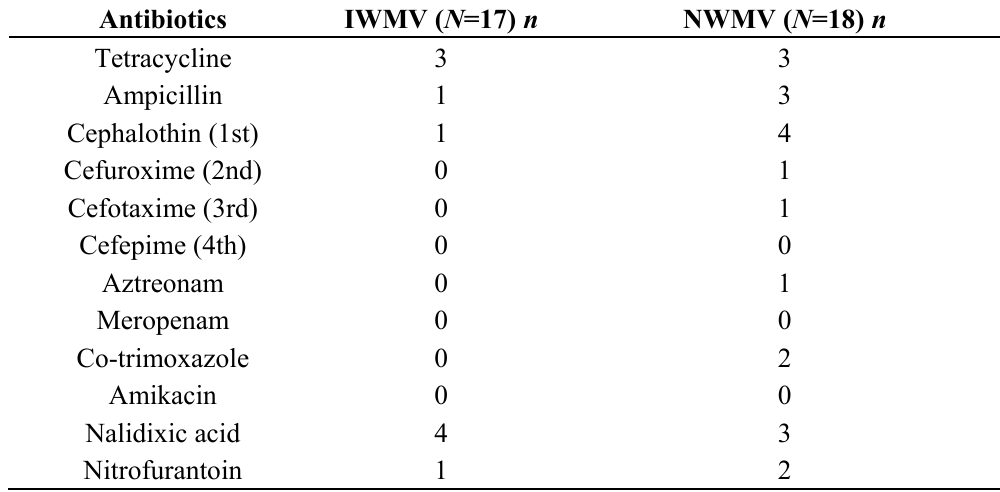
Table 5. Antibiotic resistance of Escherichia coli isolated from well water in tribal villages with and without the implementation of integrated watershed management programme Antibiotics IWMV ( N =17) n NWMV ( N =18) n Tetracycline 3 3